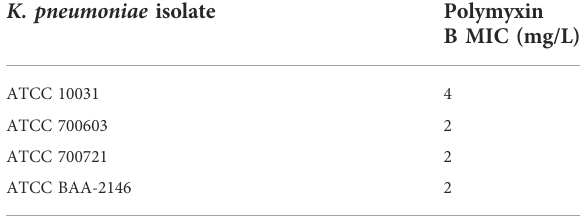
TABLE 1 MICs of K. pneumoniae